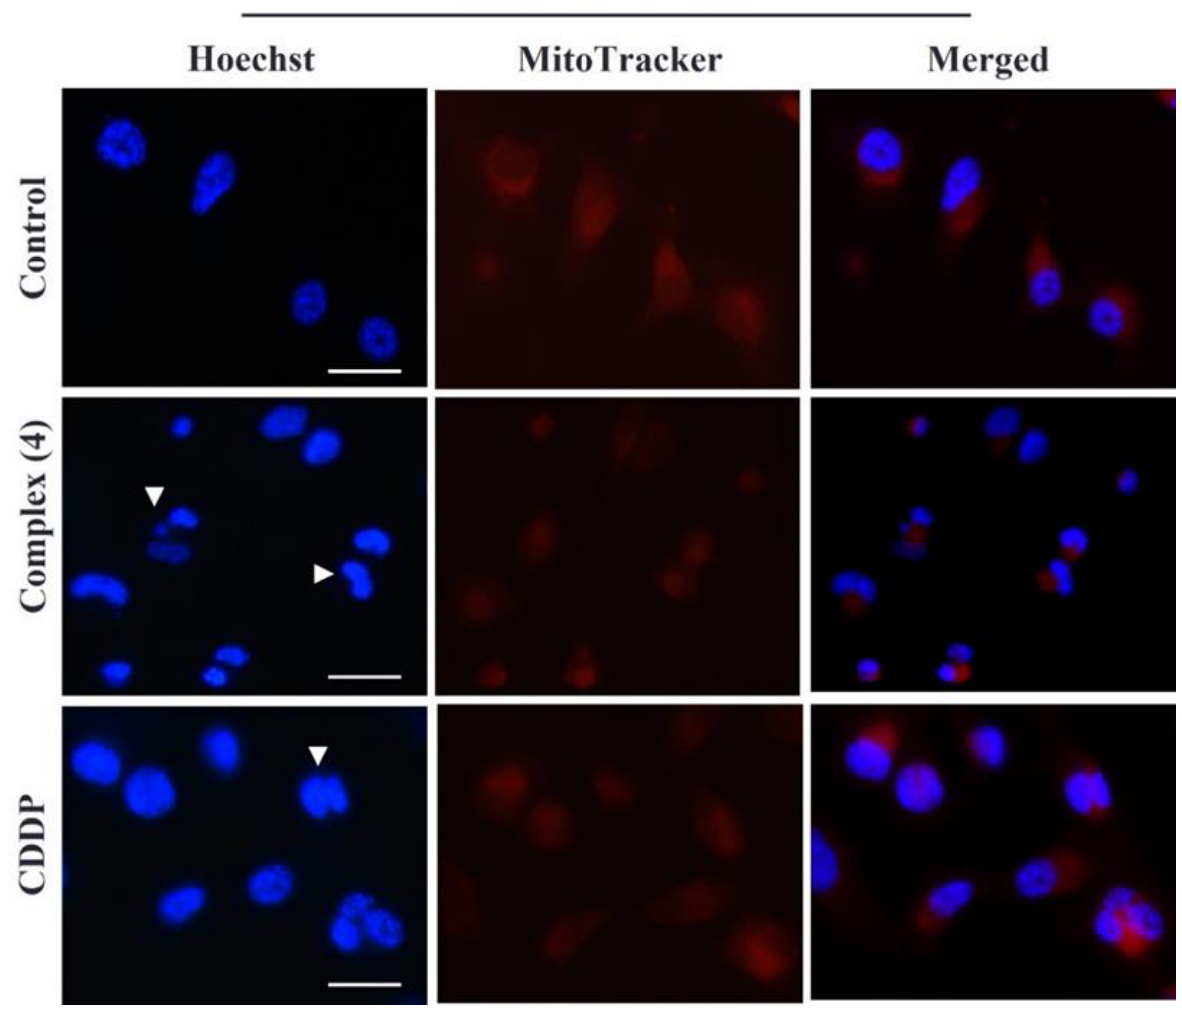
Figure 3. Morphological changes of MDA-MB-231 cells double-stained with Hoechst/MitoTracker examined under a fluorescence microscope after 12 h of incubation. Control cells. Complex ( 4 ) — cells treated with 2 × IC 50 of complex ( 4 ). CDDP — cells treated with 2 × IC 50 of cisplatin. Chromatin condensation and the pyknotic/fragmented nucleus of apoptotic cells are indicated by arrowheads. Data are representative of two independent experiments. Bars = 20 μm.